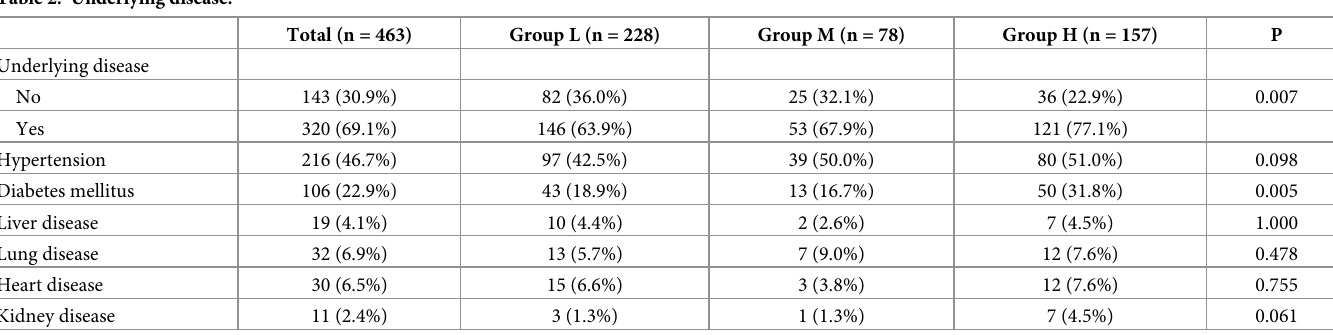
Table 2. Underlying